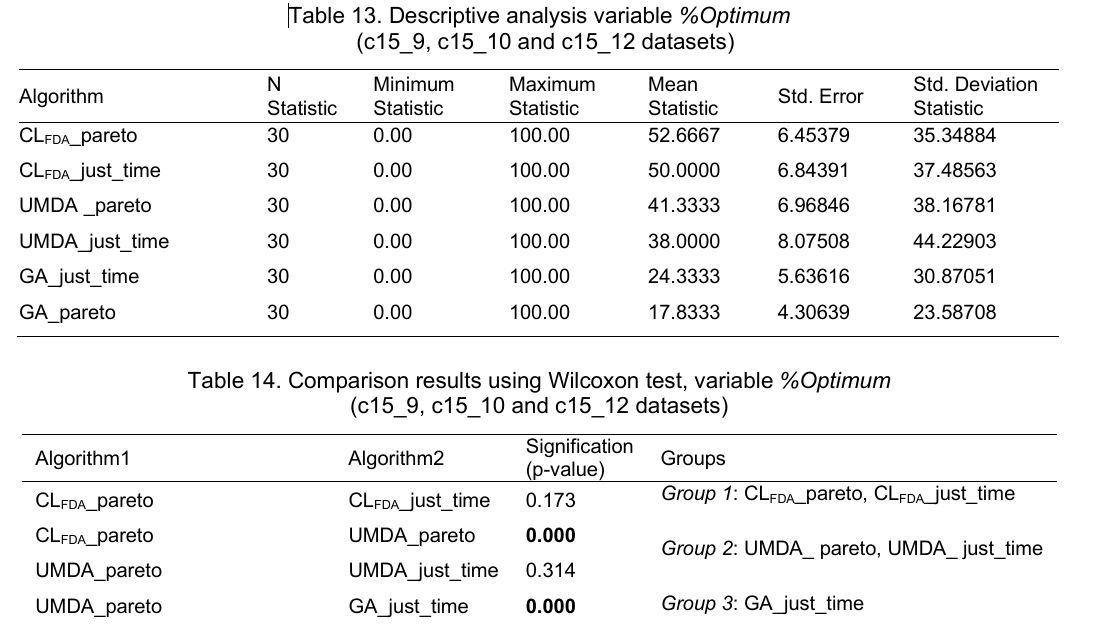
Table 13. Descriptive analysis variable %Optimum